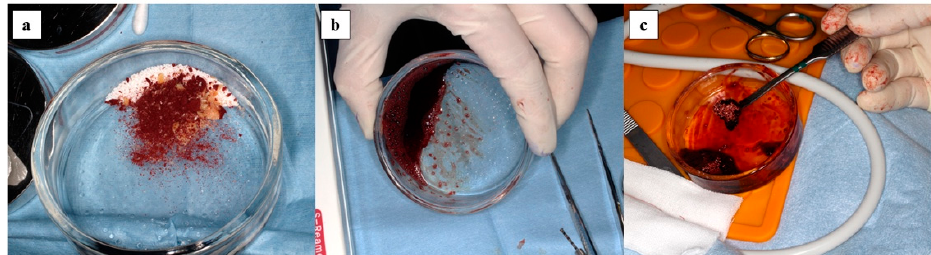
Figure 2. The preparation process for the complex of x3FD-PRP and bone grafting materials is shown: ( a ) FD-PRP powder and white particulate bone grafting materials; ( b ) complex of gelated x3FD-PRP and bone grafting materials; ( c ) given good operability.